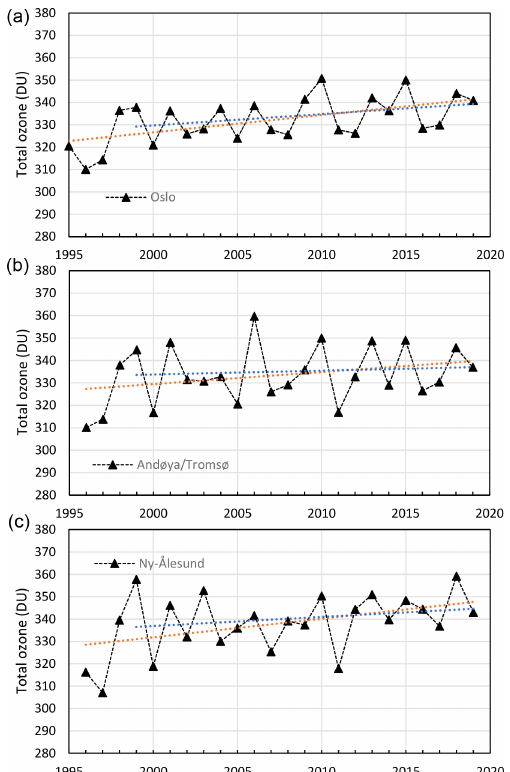
Figure 8. Annual average total ozone in Oslo, at Andøya/Tromsø, and in Ny-Ålesund. Linear trends for the whole period 1995/1996– 2019 are marked with orange lines; ozone changes for 1999–2019 are in